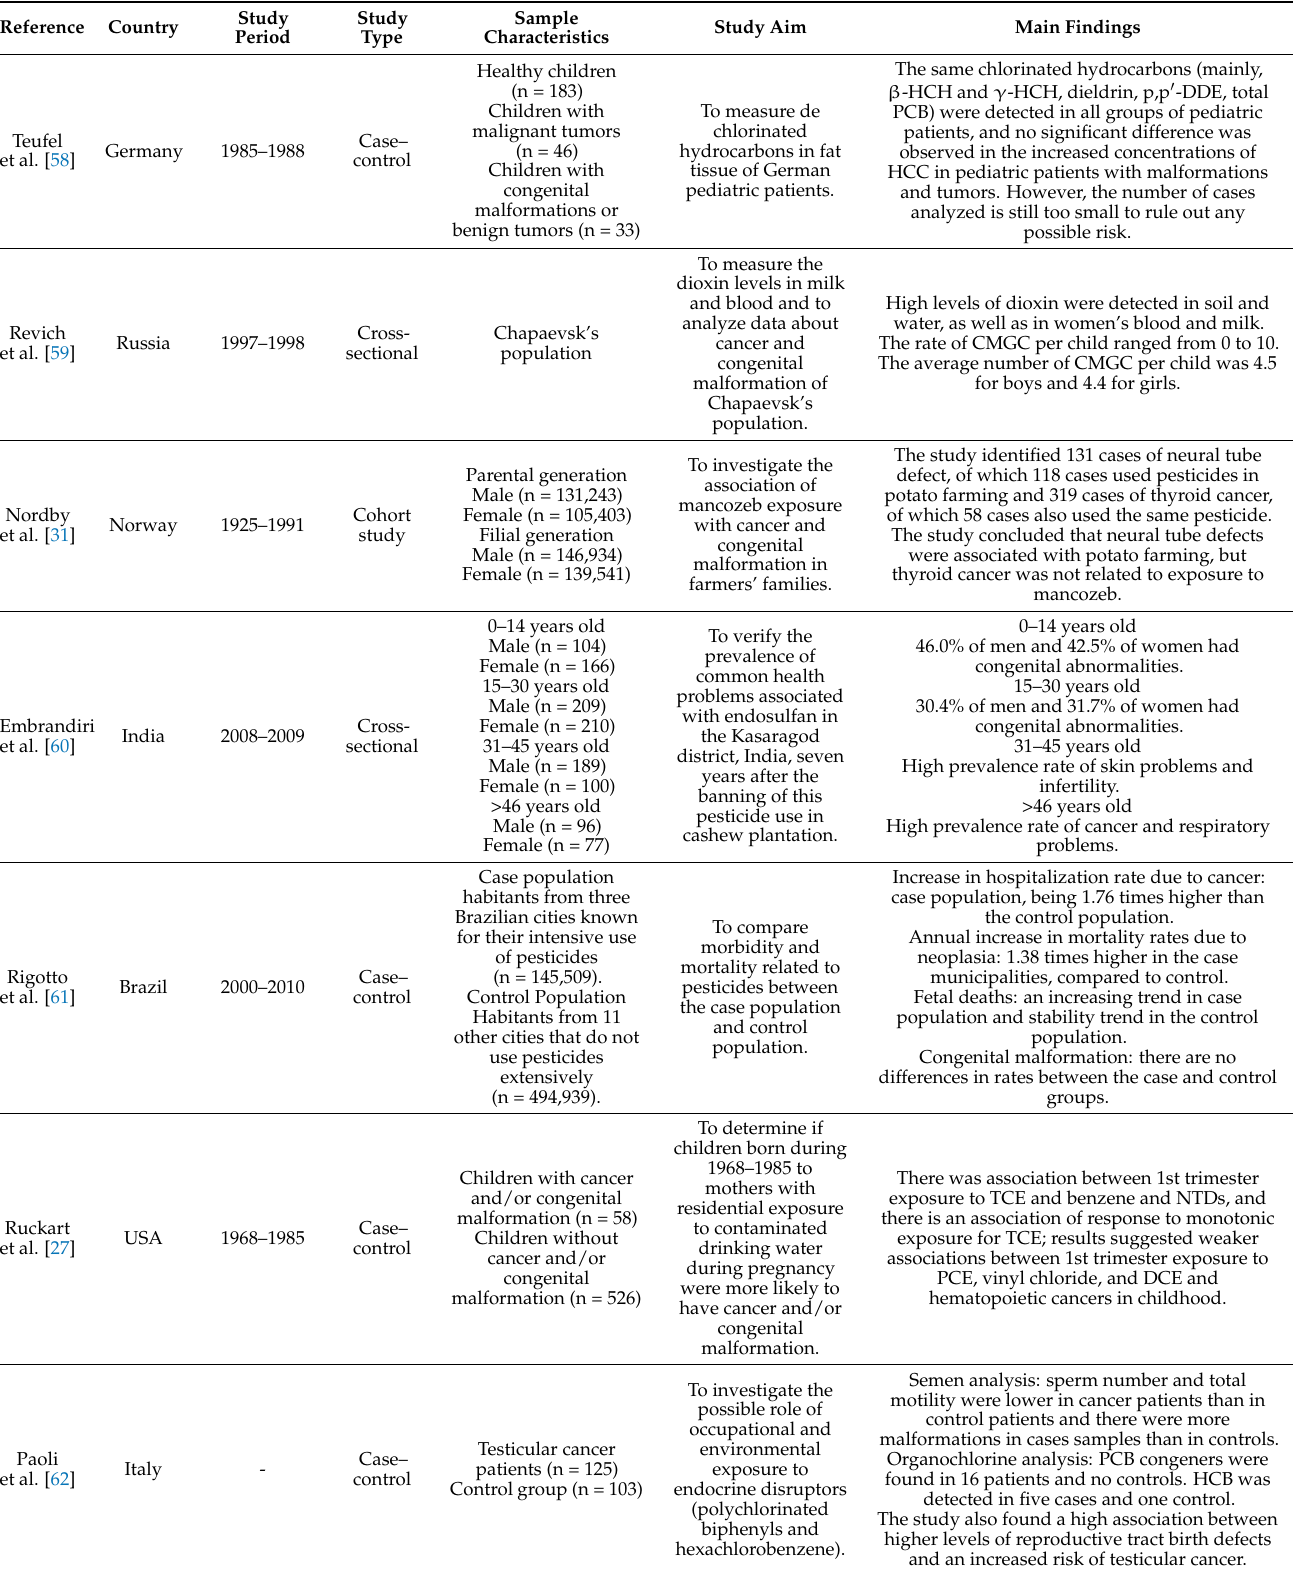
Table 3. Summary of systematically reviewed